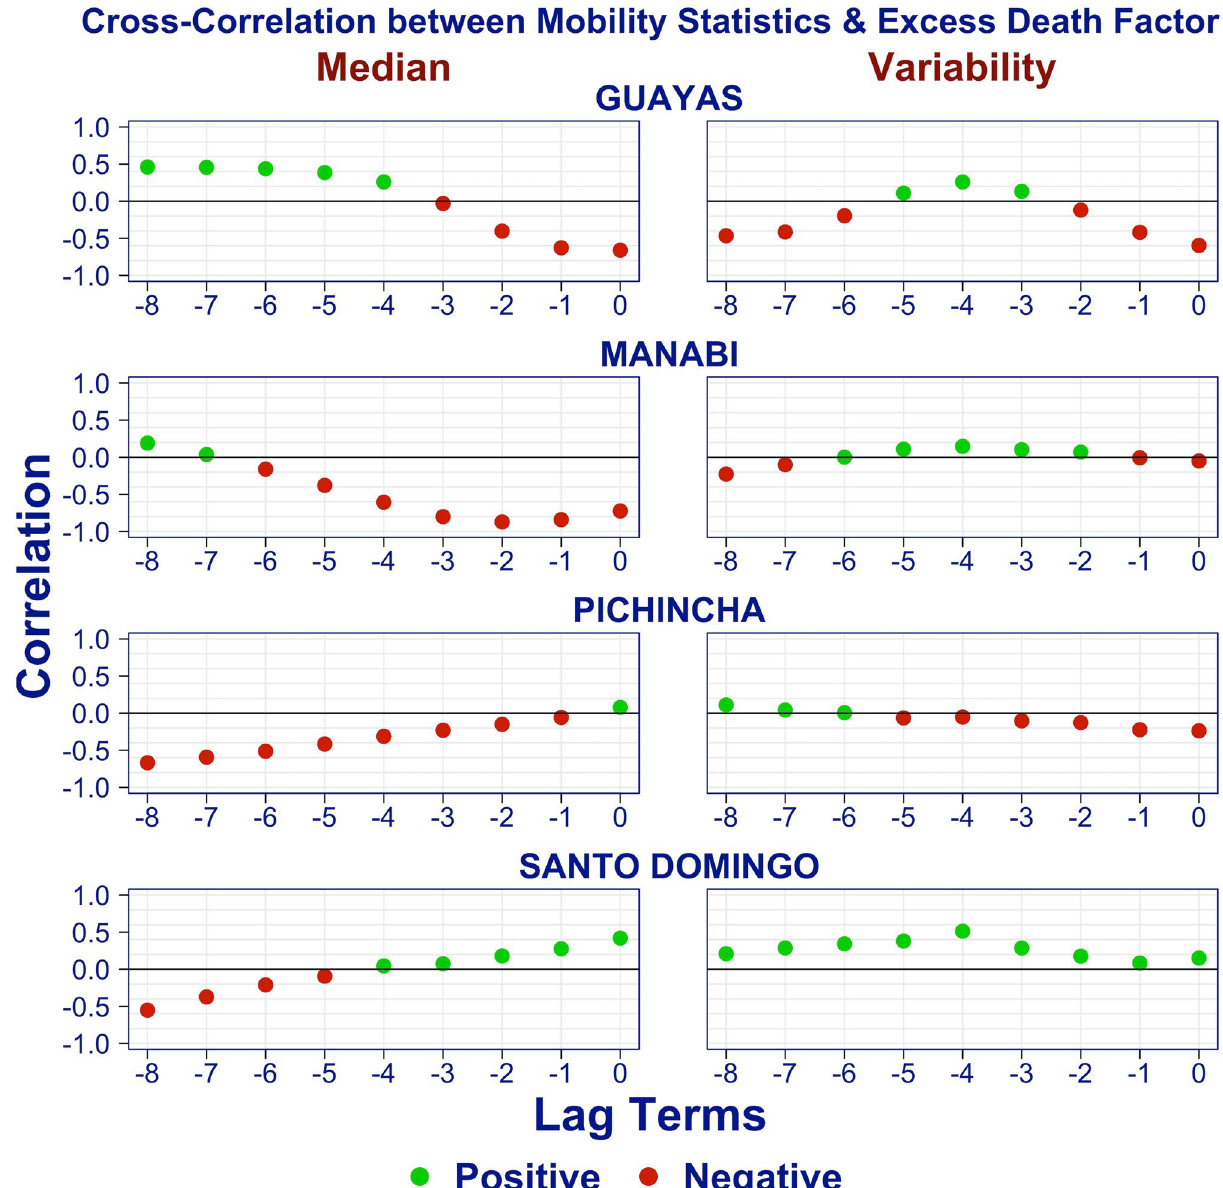
Figure 8. Cross-correlation between time series of excess death factors and mobility